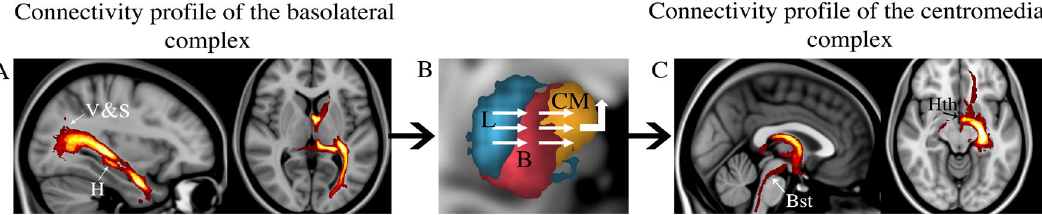
Figure 8. Functional model of the amygdala circuit. ( A ) The basolateral complex (L, B) receives and integrates information [from visual (V), sensory areas, hippocampus (H), and prefrontal cortex]. ( B ) The centromedial complex (CM) translates this information to behavior through the connections with the hypothalamus (Hth) and the brainstem